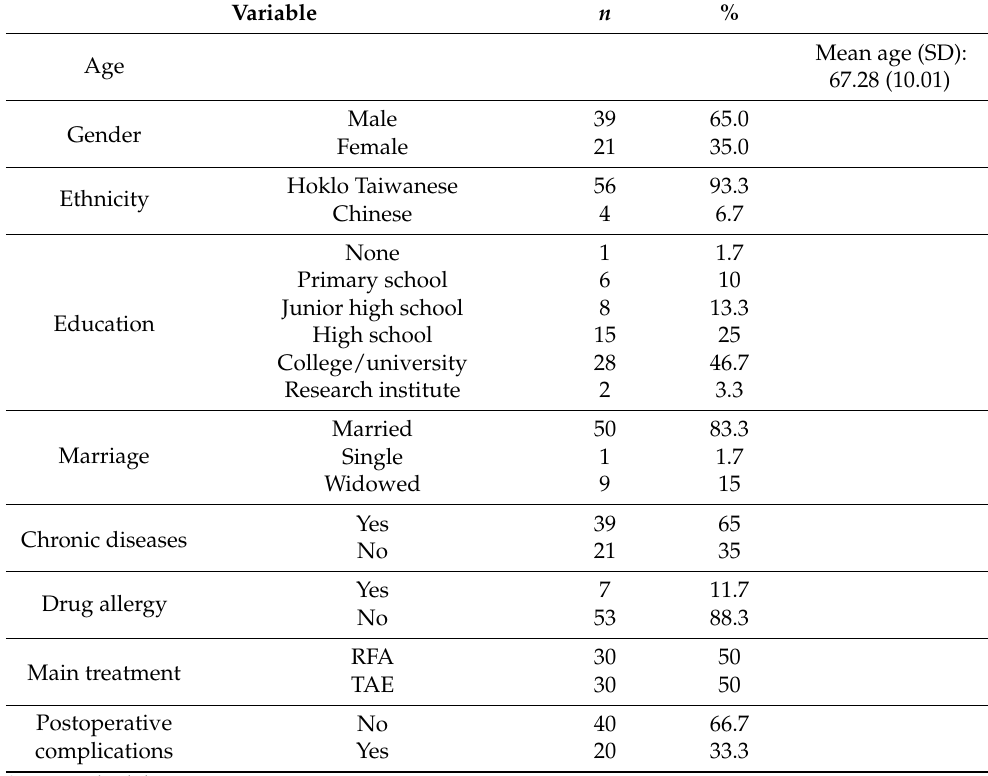
Table 1. Participant demographics (N =